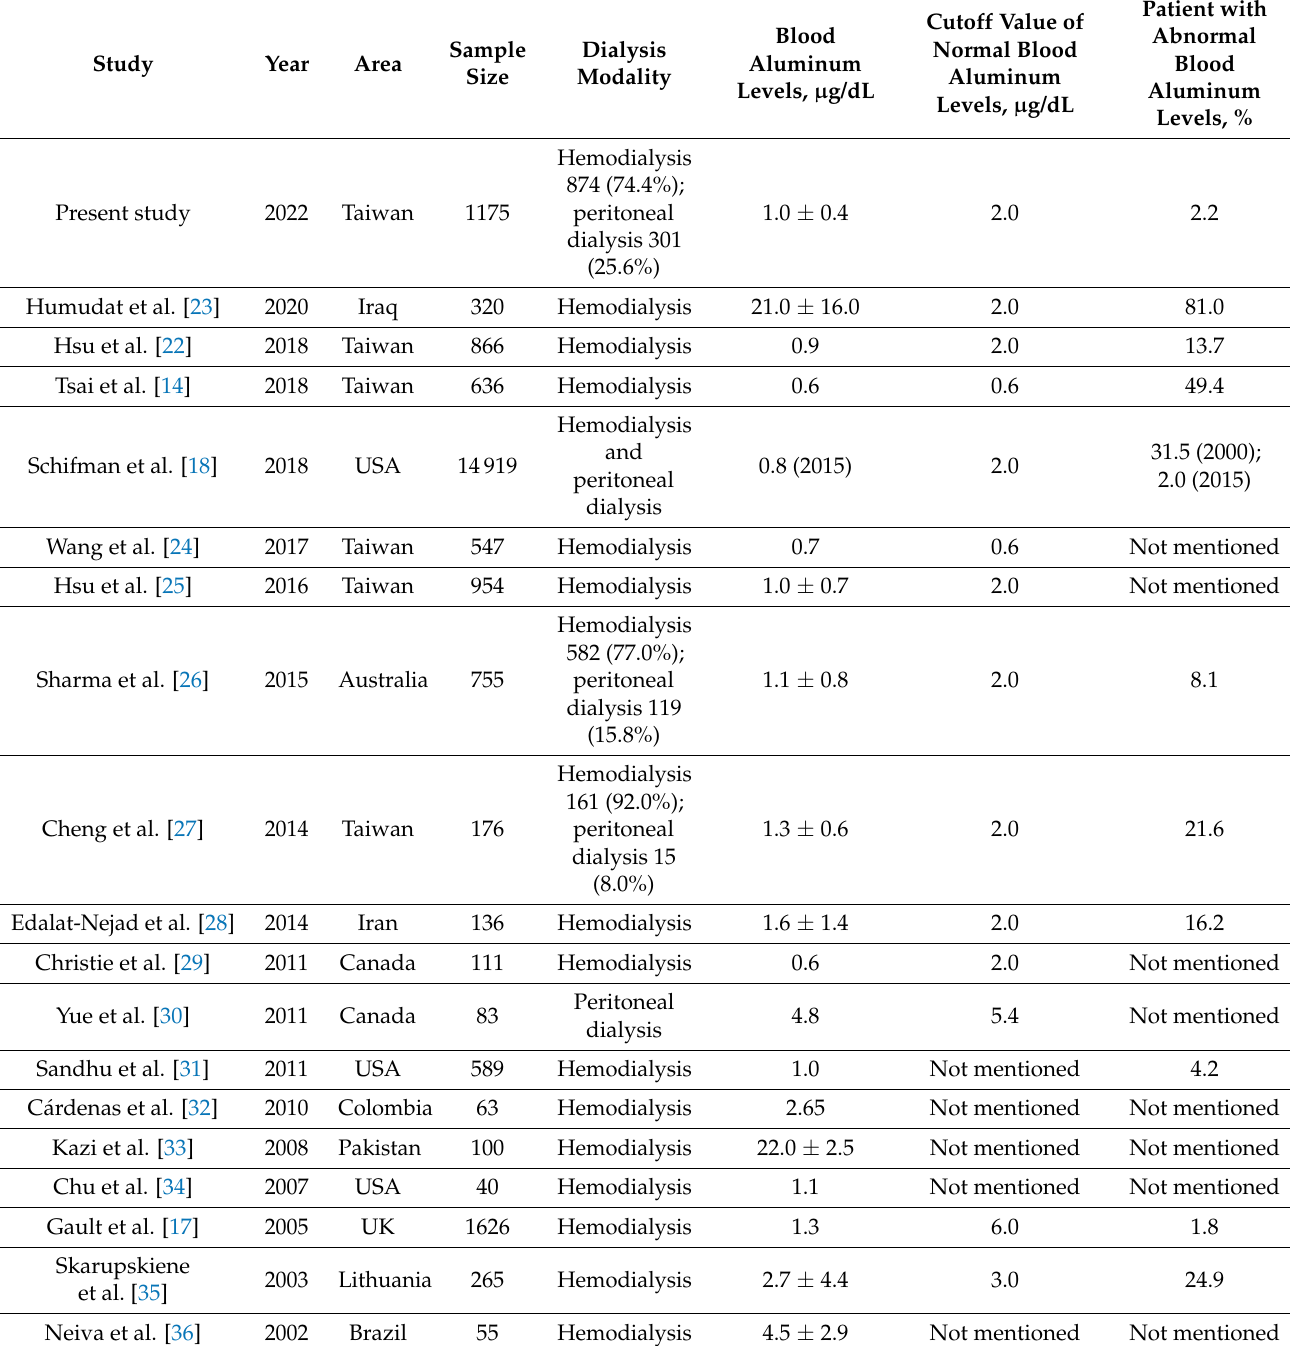
Table 3. Published studies of blood aluminum levels in chronic dialysis